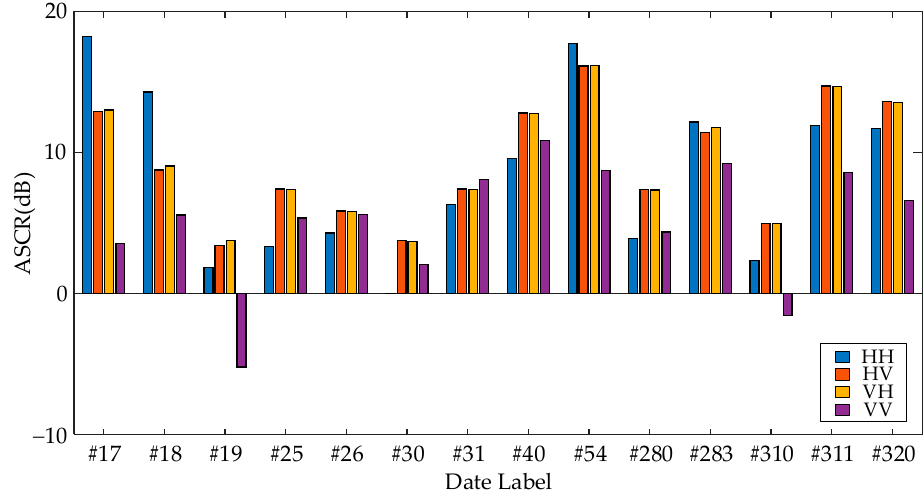
Figure 2. Average SCRs of the primary cells of the 14 datasets under four